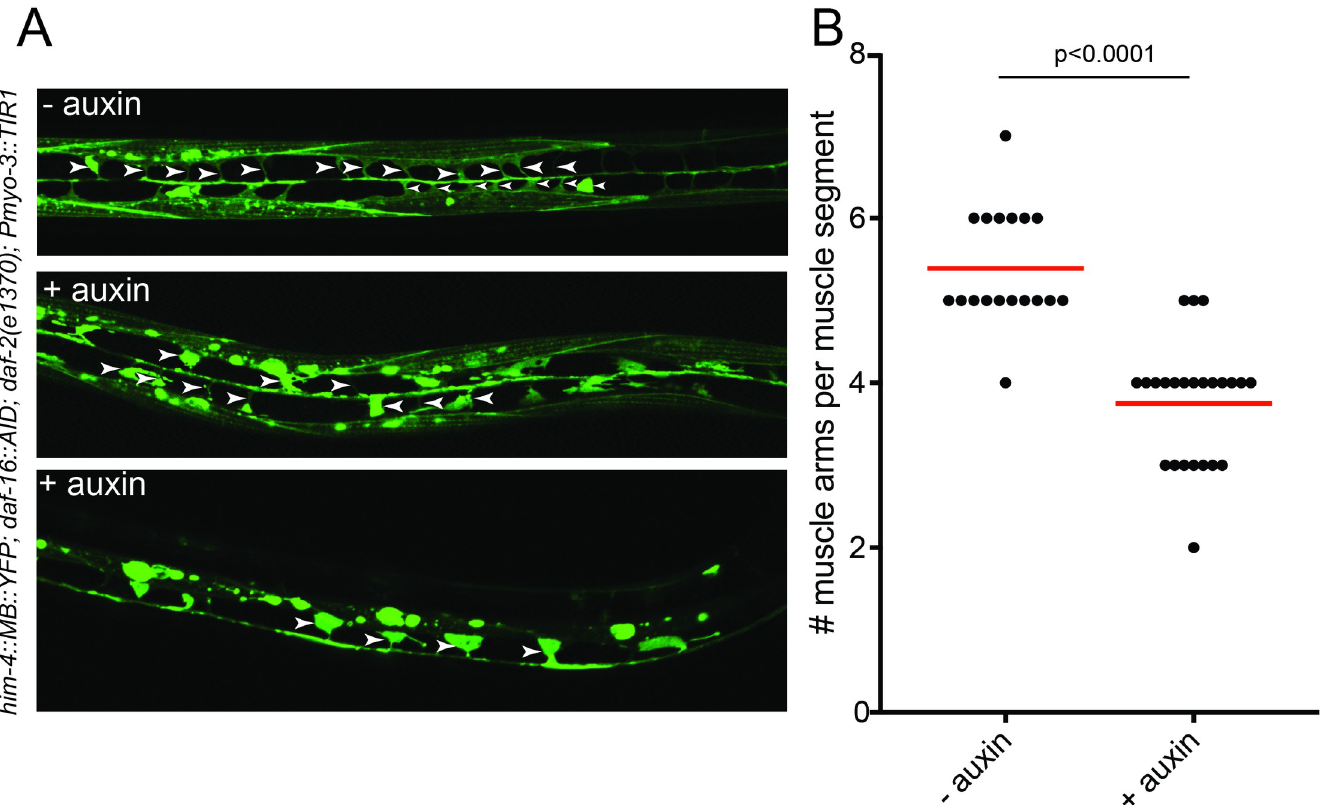
Fig 11. DAF-16/FoxO acts cell-autonomously in muscle remodeling. ( A ) Depleting DAF-16/FoxO from body wall muscle results in fewer muscle arms than in control dauers, as visualized with the trIs30[him-4p :: MB :: YFP] reporter [60]. ( B ) Quantification of the number of muscle arms per muscle segment in control and auxin-treated dauers. The data underlying this figure can be found in S1 Data. AID, auxin-inducible degron.